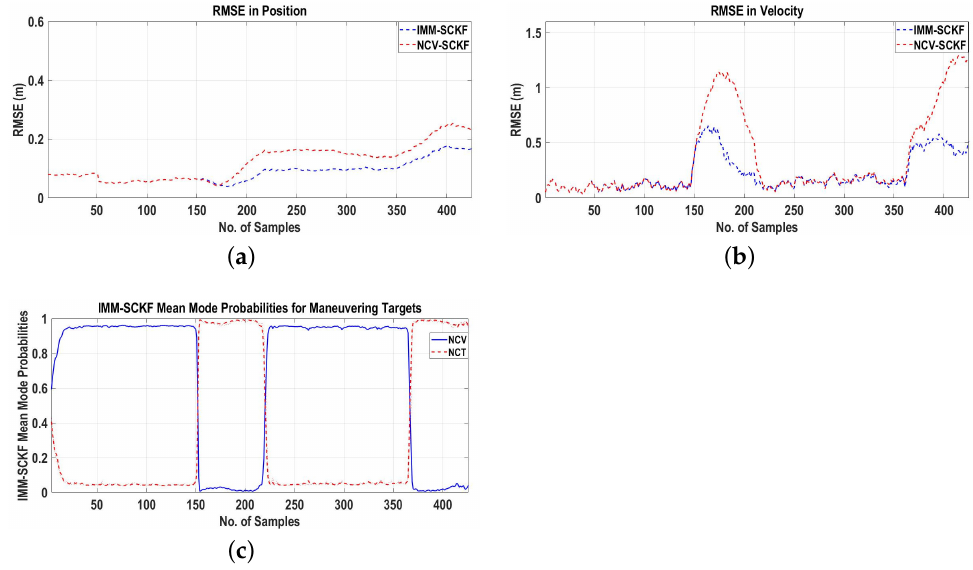
Figure 12. RMSEs in position and velocity and IMM-SCKF mean model probabilities for maneuvering targets for Scenario 2. ( a ) RMSE in position; ( b ) RMSE in velocity; ( c ) IMM-SCKF mean model